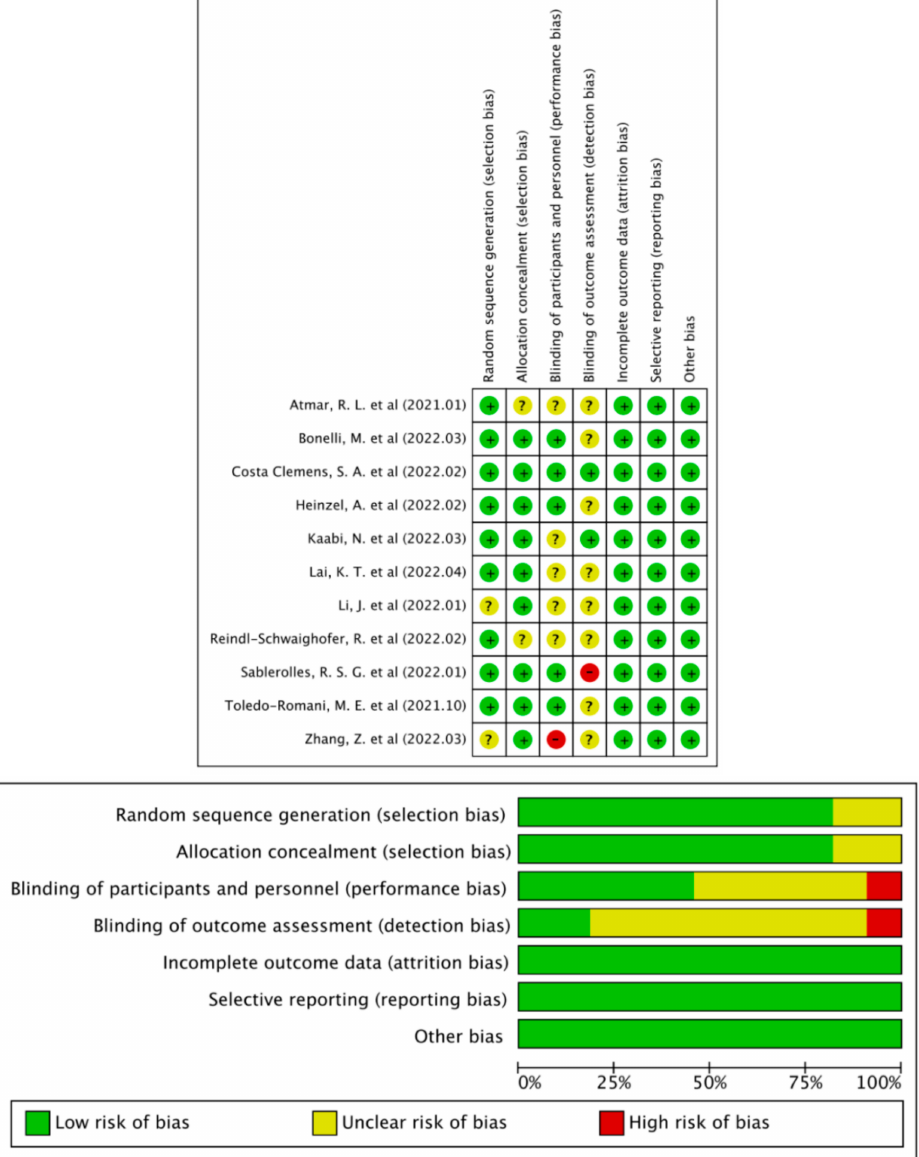
Figure 2. Risk of bias assessment of the included RCTs